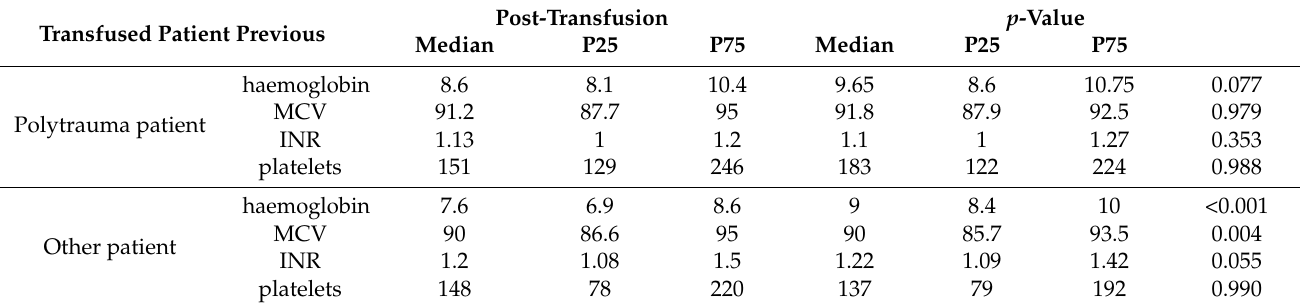
Table 5. Difference between pre-transfusion and post-transfusion blood levels.